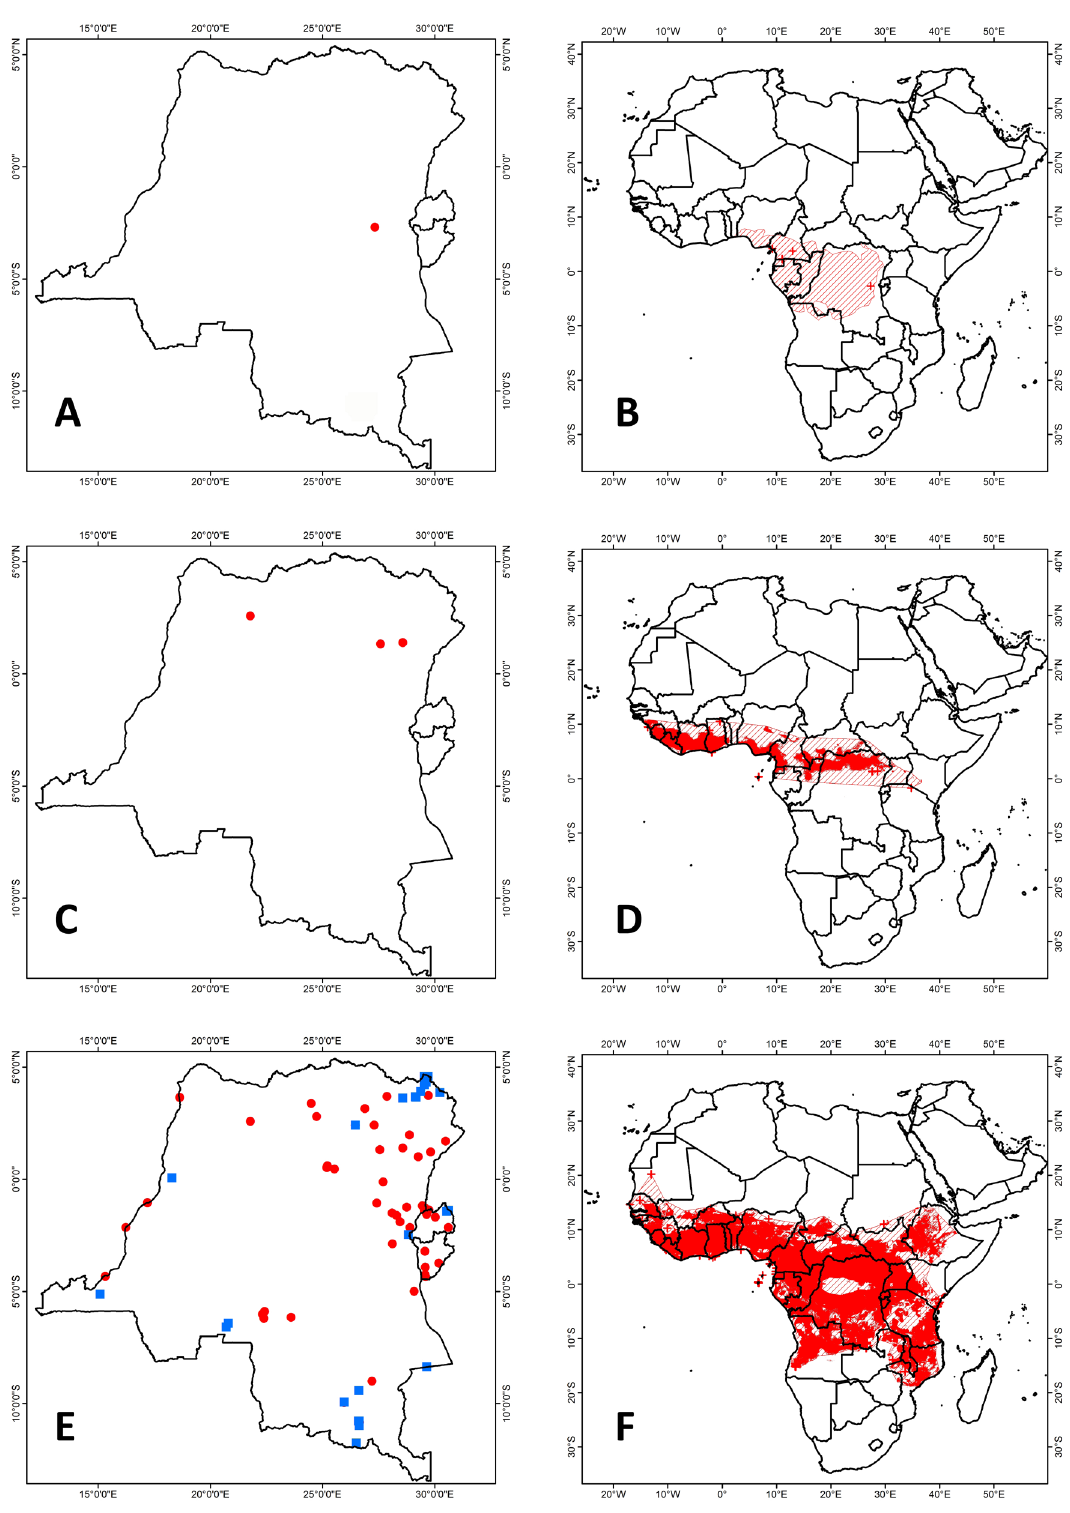
Fig. 12. Distribution maps. A–B . Hipposideros camerunensis Eisentraut, 1956. C–D . Hipposideros fuliginosus (Temminck, 1853). E–F . Hipposideros ruber (Noack, 1893). A, C, E. Distribution in